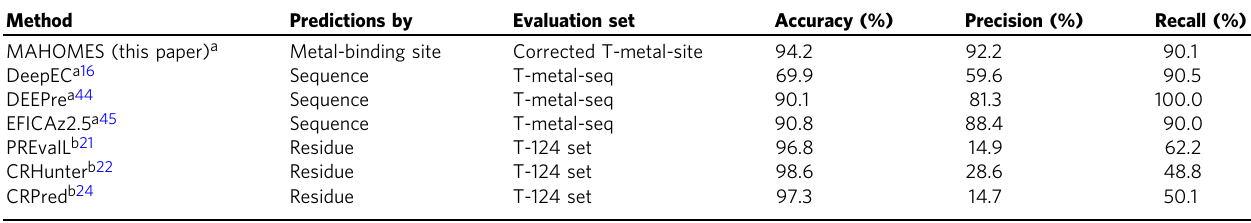
Table 1 Comparison of MAHOMES performance to similar tools that make enzymatic and non-enzymatic predictions. Method